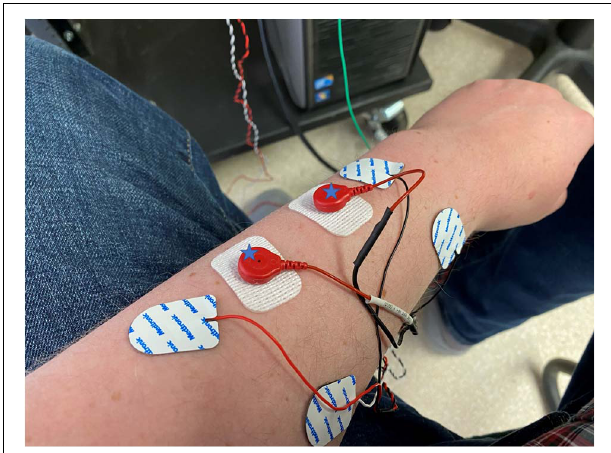
FIGURE 1 | The placement of electrodes on the forearm of a subject with the stimulation electrodes being the white rectangular electrodes, marked with a star, and the recording electrodes being rounder with a built-in cable. Stimulating and recording electrodes are placed in close proximity to each other and aligned parallel to the muscle fibers.